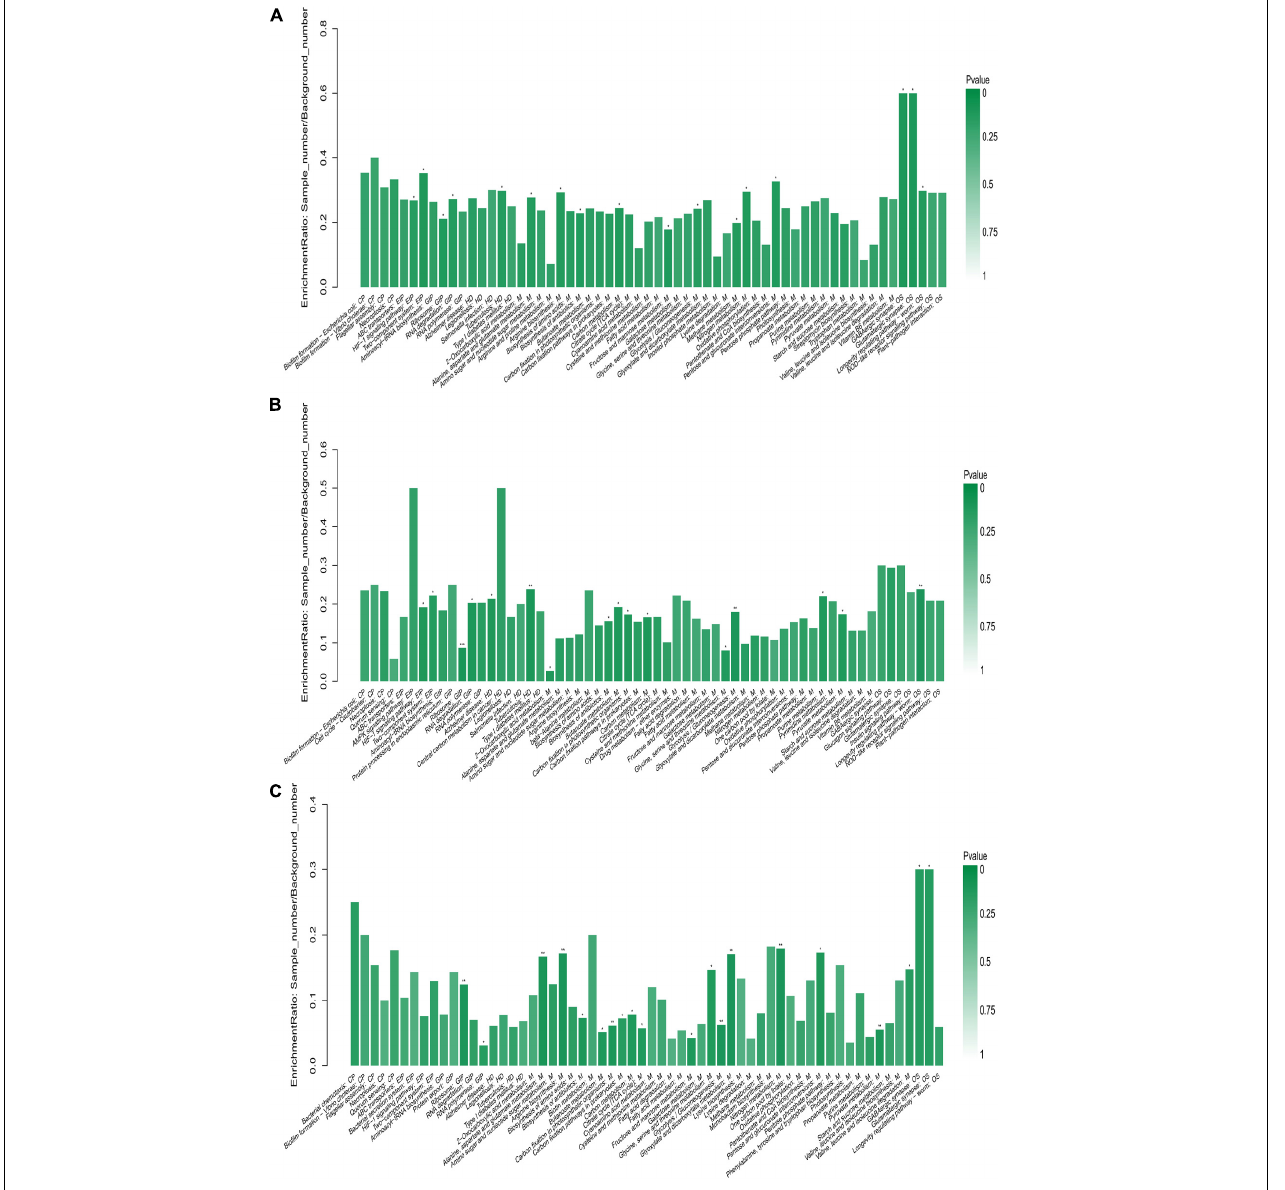
FIGURE 5 | KEGG enrichment of differentially expressed proteins. (A) KEGG enrichment analysis of all differentially expressed proteins. (B) KEGG enrichment analysis of all up-regulated differentially expressed proteins (experimental group vs. control group, EG vs. CG). (C) KEGG enrichment analysis of all down-regulated differentially expressed proteins (experimental group vs. control group, EG vs. CG). CP, cellular processes; EIP, environmental information processing; GIP, genetic information processing; HD, human diseases; M, metabolism; and OS, organismal systems.